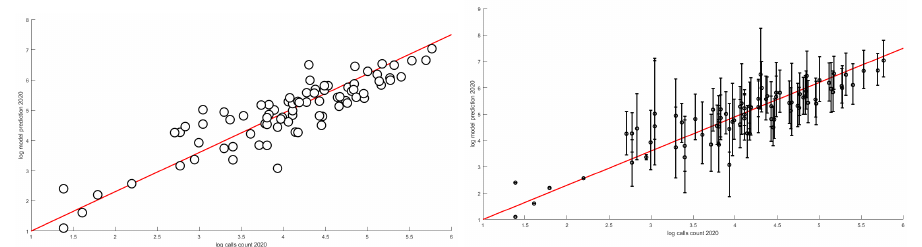
Figure 20. Scatter plot and error bar plot between the log median predictions and log real values for 2020. The circles in the scatter plot represent individual neighbourhoods in Valencia, and the red line refers to the ideal prediction. The error bars represent the 99% confidence intervals for the predicted values.